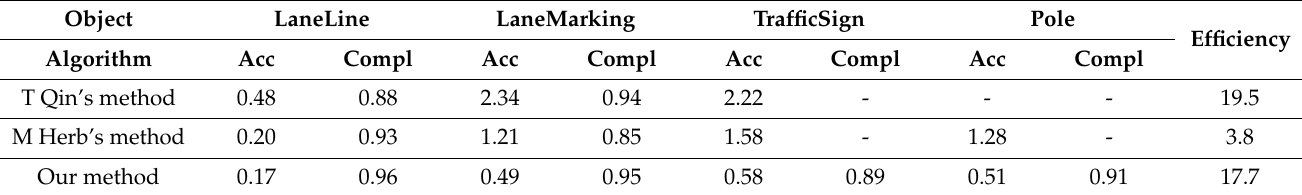
Table 3. Performance comparison of three crowdsourced mapping